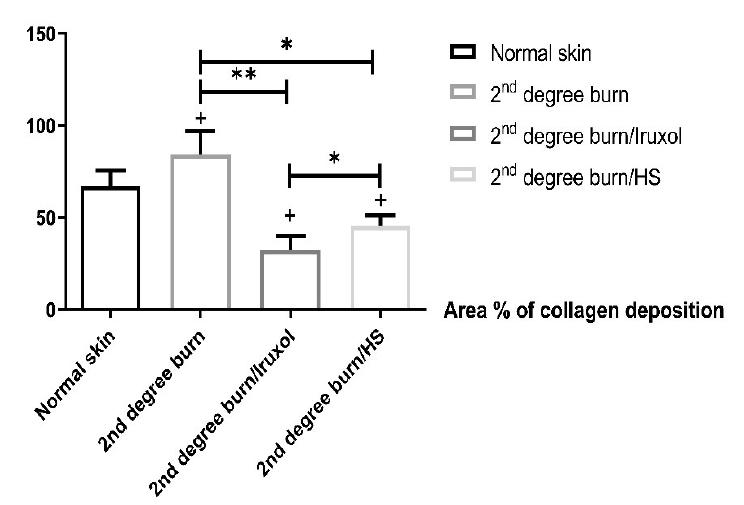
Figure 2. Percentage of collagen deposition. HS: Hibiscus sabdariffa, +, ( p < 0.05) vs. normal group; *, **, significant difference between indicated pairs ( p < 0.05, p < 0.01, respectively). Differences between groups were examined by ANOVA/Tukey’s Kramer multiple comparison test. n = 6.